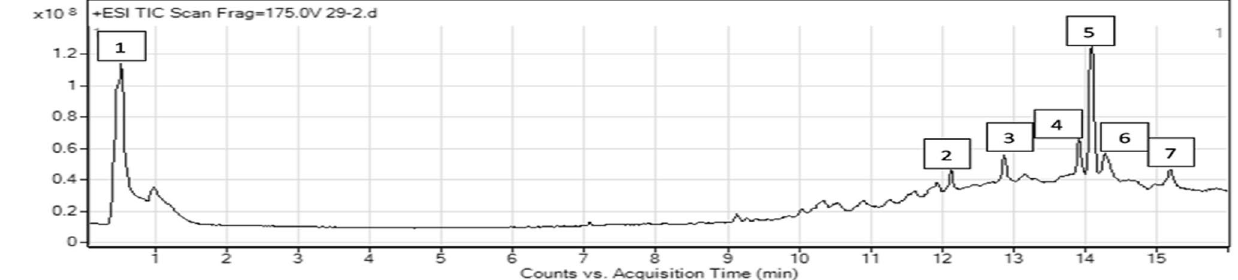
Figure 12. Metabolomic profiling using LC–MS, chromatogram of F. venenatum extract presenting the molecular mass for different